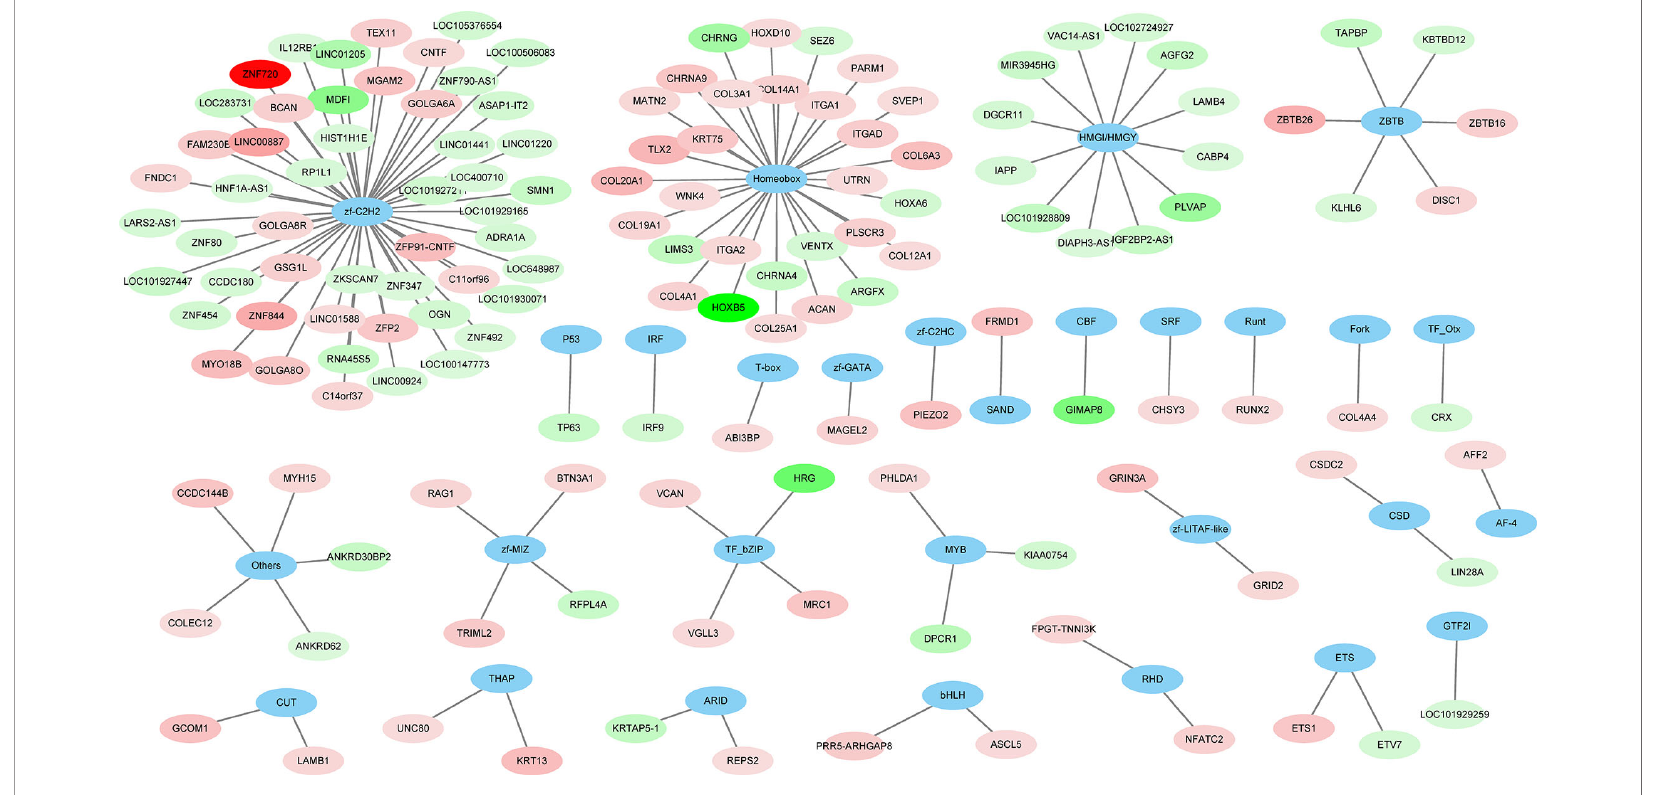
FIGURE 5 | The families of differentially expressed transcription factors (DETFs). A total of 144 DETFs were categorized into 29 transcription families. Blue ovals represent the TF family. Red and green ovals represent TF with increased and decreased expression, respectively. The details of DETFs are listed in Supplementary Table S2